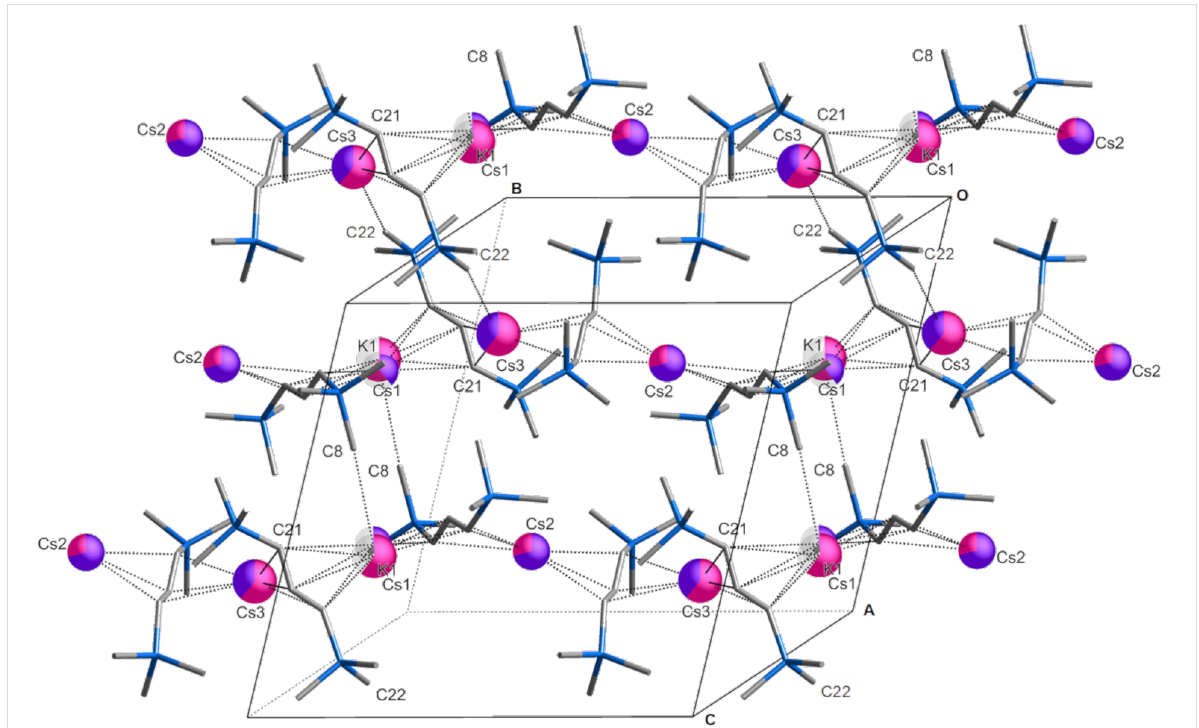
Figure 2: Partial packing diagram of [CsKA' 2 ], illustrating some of the interchain contacts, predominantly K1 … C8 at 3.20 Å, and Cs3 … C22 at 3.44 Å, that promote sheet formation. The metal centers are colored in a pie chart fashion according to the proportion of K + (purple) or Cs + (pink) of each; translucent wedges (visible on K1 and Cs1) indicate the percentage of partial vacancy at the site. The C–C and C–Si bonds are rendered as sticks.